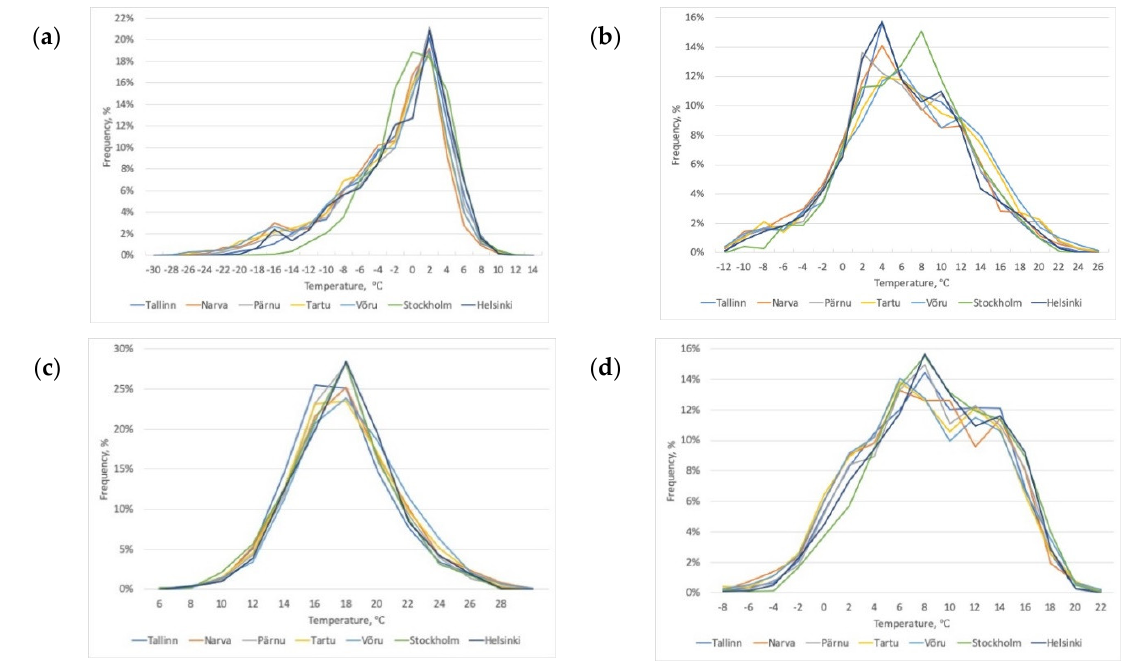
Figure 6. Frequency distribution of the average daily surface air temperatures during different periods: ( a )—December to February, ( b )—March to May, ( c )—June to August, ( d )—September to November. Percentages are calculated for 2 °C intervals.